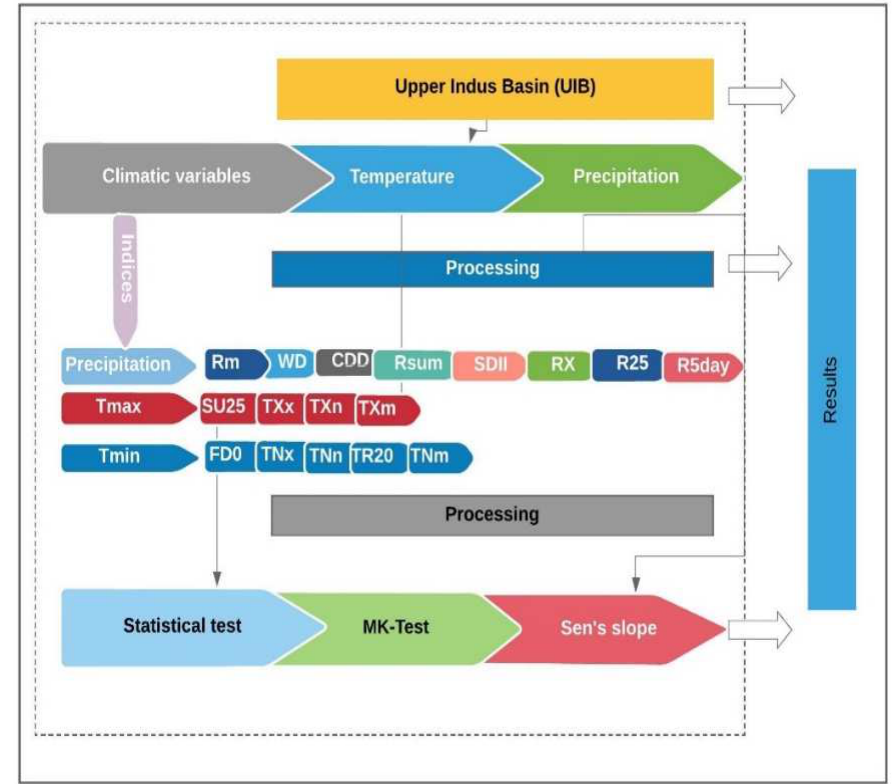
Figure 2. Methodology flowchart for trend analysis of climatic extremes.